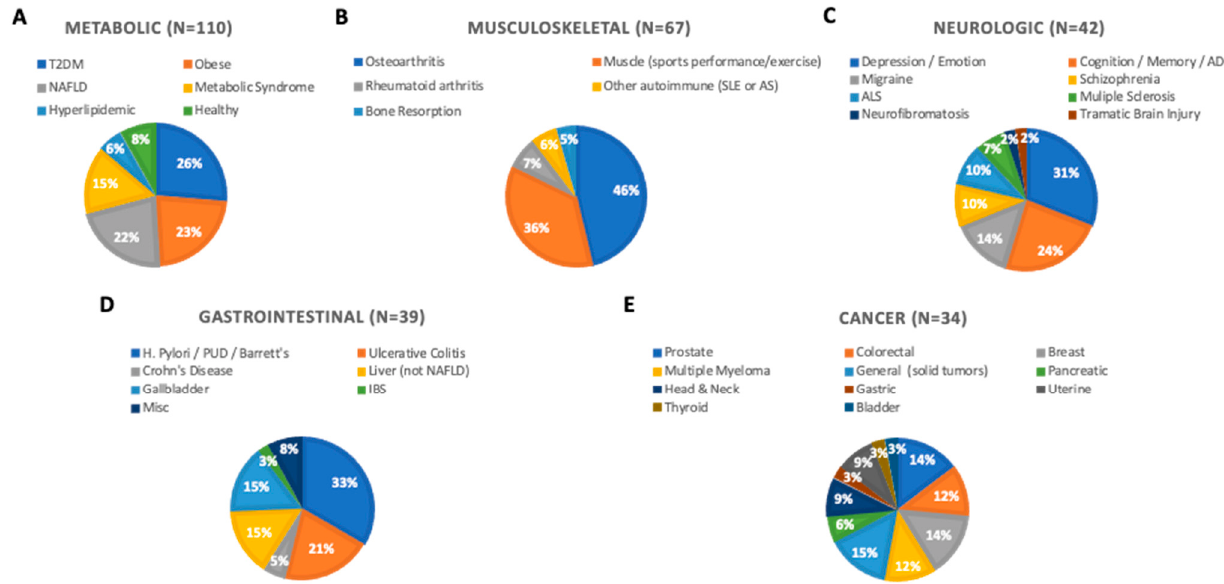
Figure 6. Frequency of specific conditions studied within each of the top five categories, which to- gether accounted for 75% of curcumin clinical trial citations. N = number of citations.